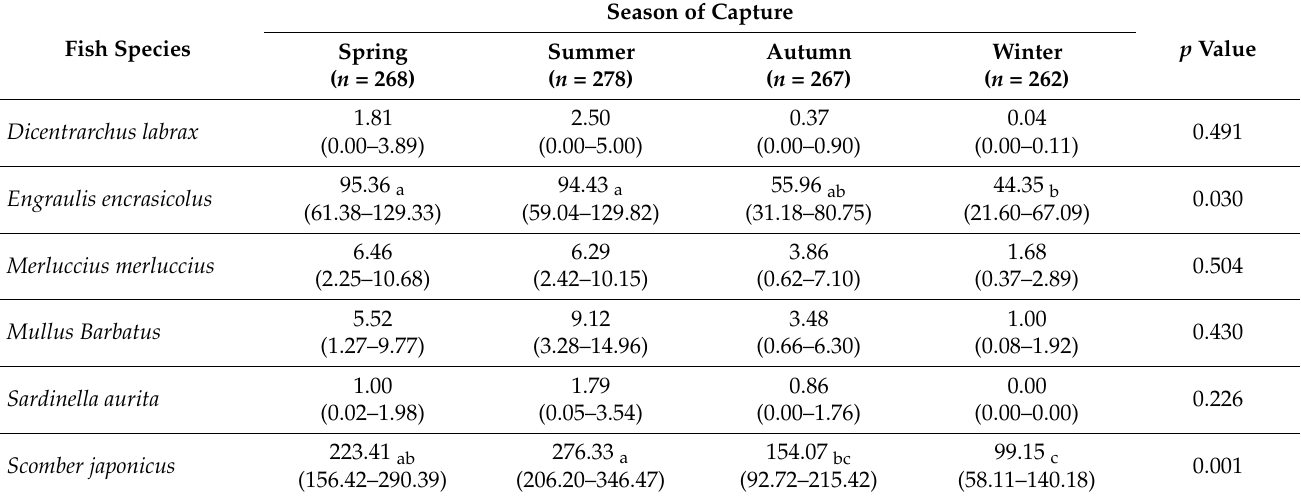
Table 4. Mean abundance with 95% confidence intervals (calculated using the bootstrap method) of anisakid L3 type I larvae in the fish species, analyzed with respect to the season of capture. Values followed by the same letters are not significantly